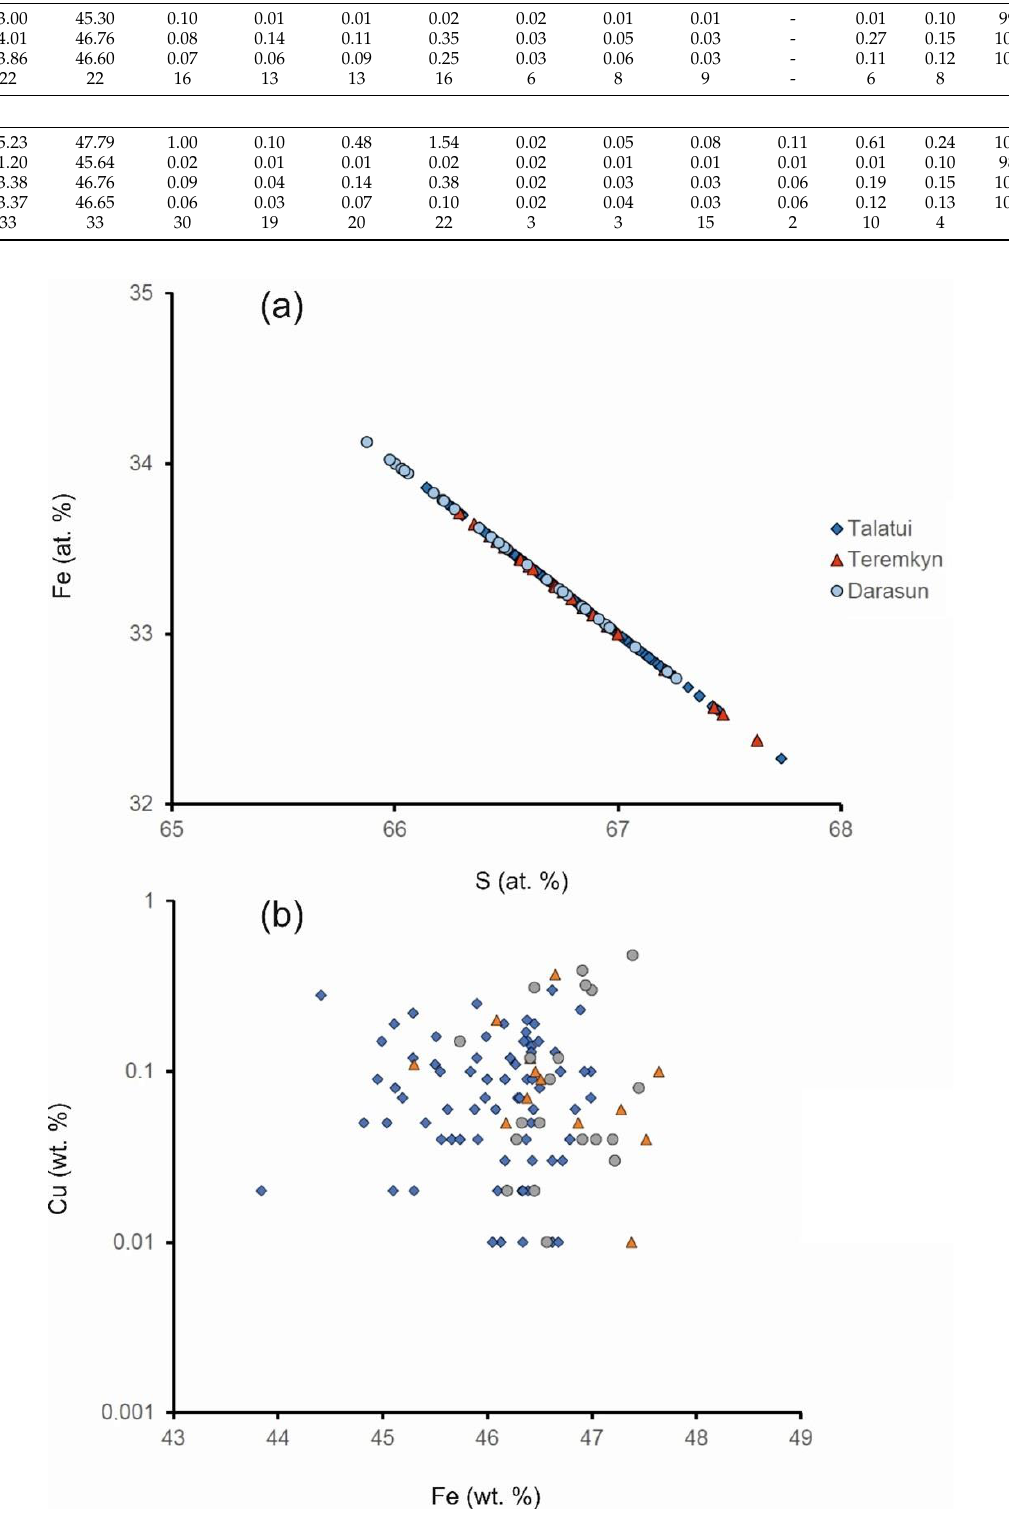
Figure 5. Binary plots of ( a ) Fe vs. S, ( b ) Cu vs. Fe in the pyrite samples from the deposits of the Darasun goldfield. EPMA data.